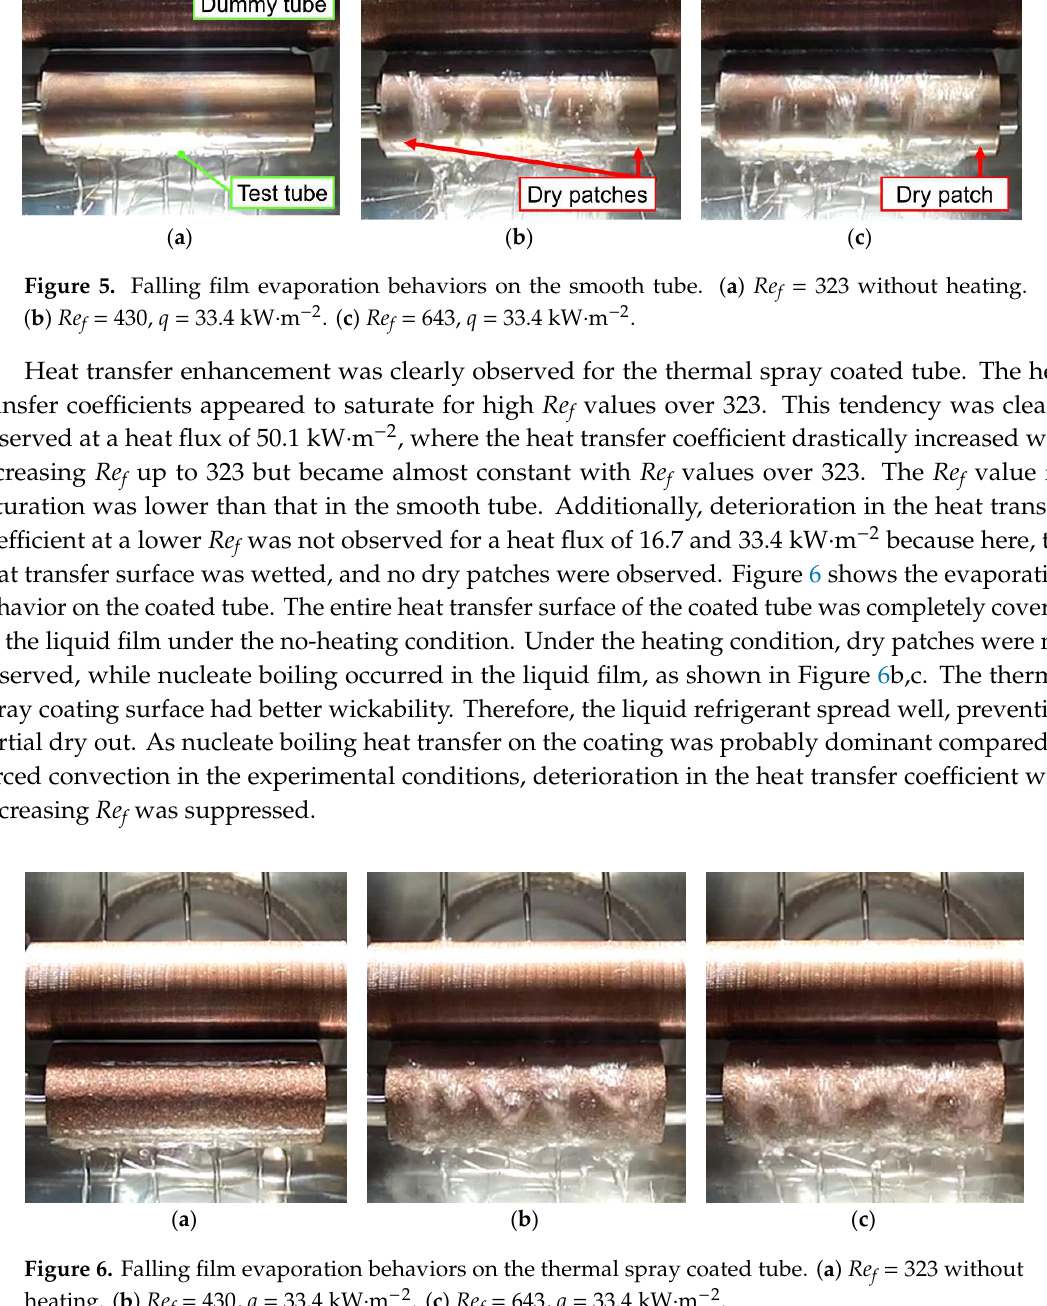
Figure 6. Falling film evaporation behaviors on the thermal spray coated tube. ( a ) Re f = 323 without heating. ( b ) Re f = 430, q = 33.4 kW·m −2 . ( c ) Re f = 643, q = 33.4 kW·m −2 .